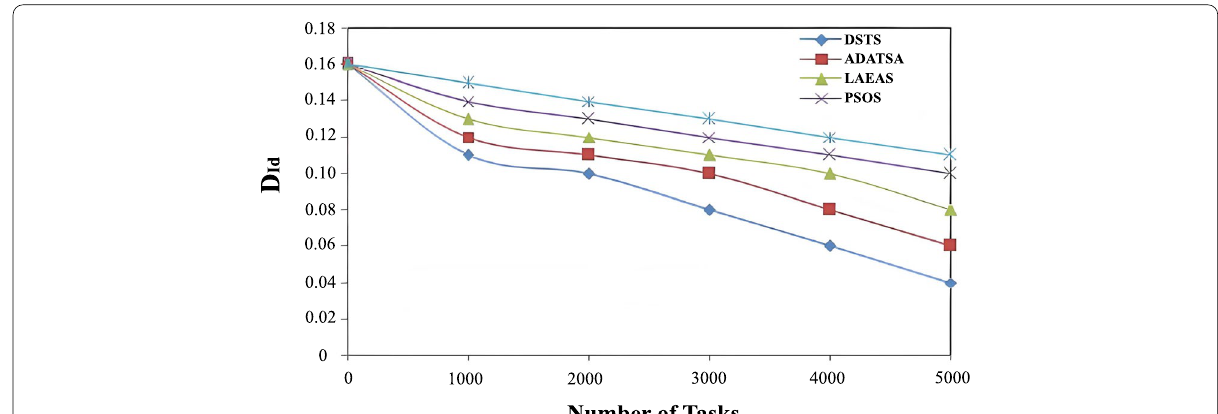
Fig. 2 Comparative analysis of resource imbalance degree (D Id ) (Task-1)